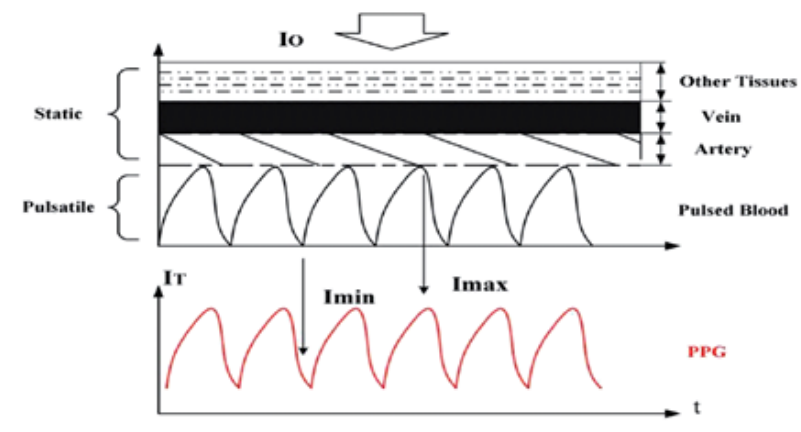
Fig. 3. Multilayer structure of the tissue.